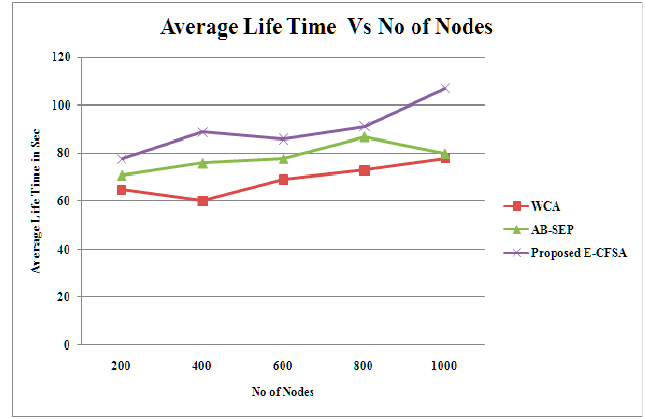
Figure 20. Graph Avg Lifetime Vs. No. of Nodes.